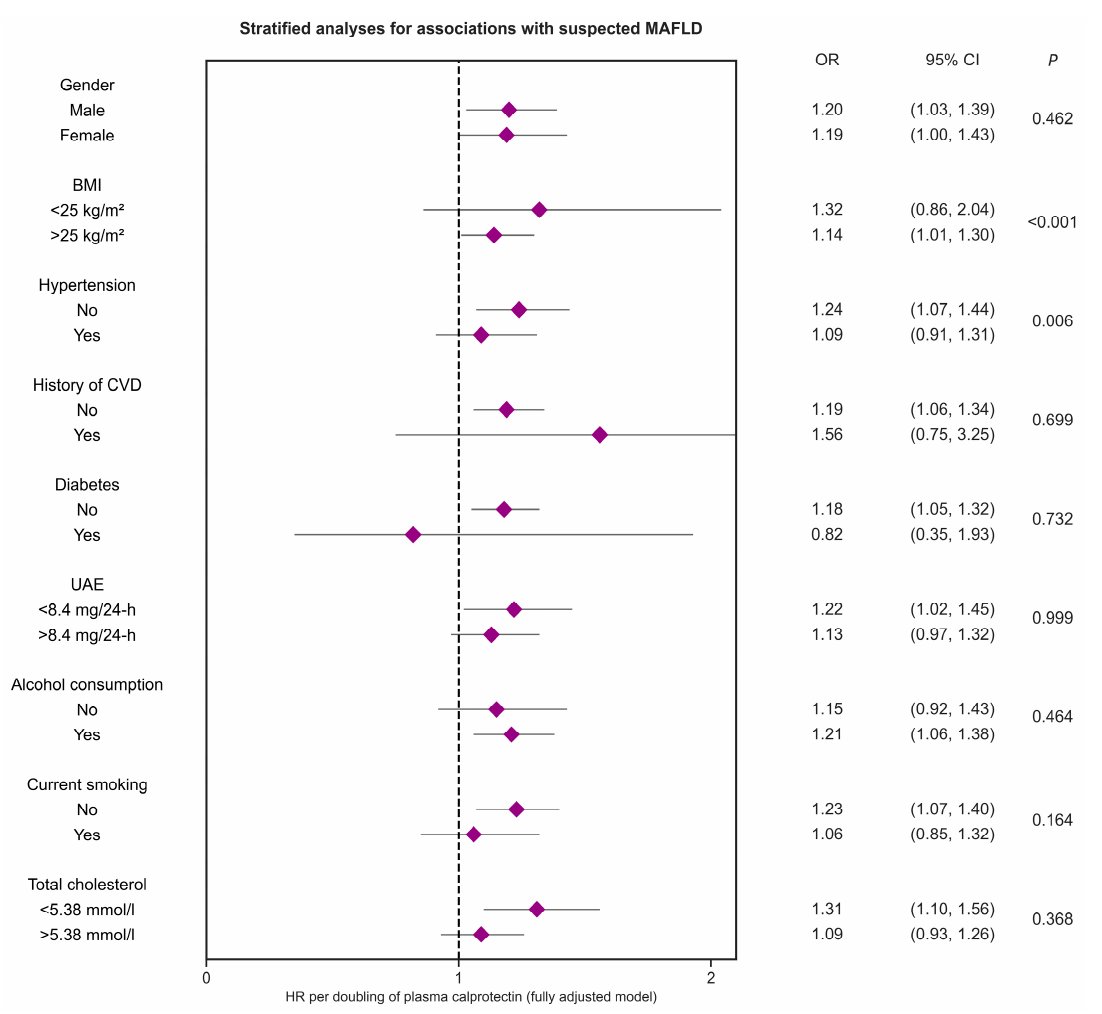
Figure 1. Stratified analyses for the association between plasma calprotectin levels and suspected MALFD (FLI ≥ 60) across various subgroups. Odds ratios (ORs) with corresponding 95% confidence intervals derived from multivariable logistic regression analyses are shown. p -values indicate p -values for interaction terms. First, we tested for potential effect modification for the variables shown, and subsequently performed stratified analyses. ORs demonstrate almost consistently positive associations between plasma calprotectin levels and the risk of all-cause mortality in all analyzed subgroups. ORs were adjusted for potential confounding factors, including all factors incorporated in Model 4 (Table 2). Abbreviations: CI, confidence interval; BMI, body mass index; CVD, cardiovascular disease; HR, hazard ratio; UAE, urinary albumin excretion.